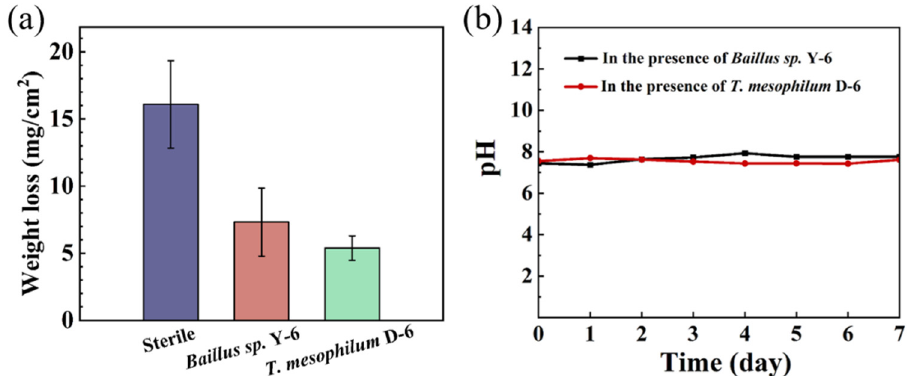
Figure 4. Weight loss of Q235 carbon steel ( a ) and pH variation ( b ) in different culture. The black curve and red curve represent the pH change of Bacillus sp. Y-6 and T. mesophilum D-6, respectively.